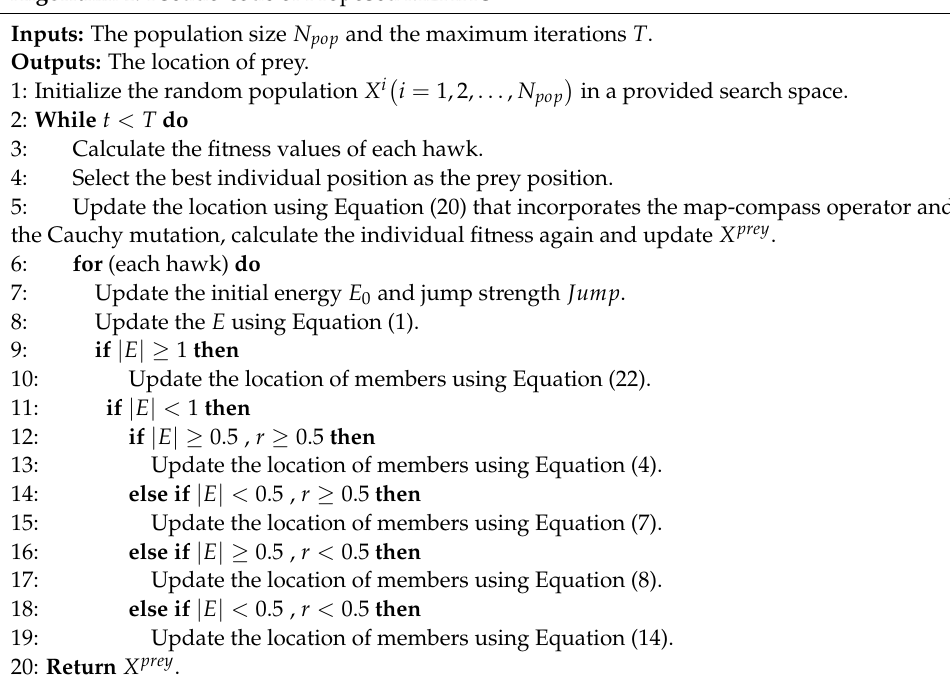
Algorithm 1. Pseudo-code of Proposed MEHHO